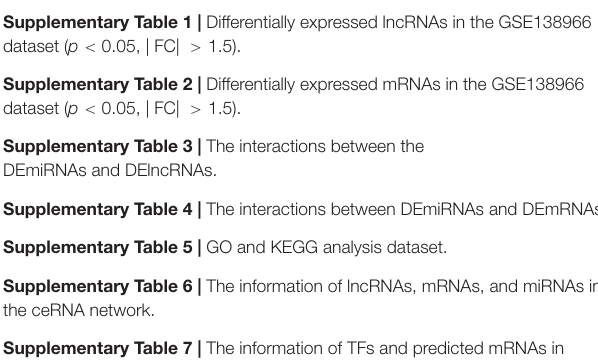
Supplementary Table 3 | The interactions between the DEmiRNAs and DElncRNAs. Supplementary Table 4 | The interactions between DEmiRNAs and DEmRNAs. Supplementary Table 5 | GO and KEGG analysis